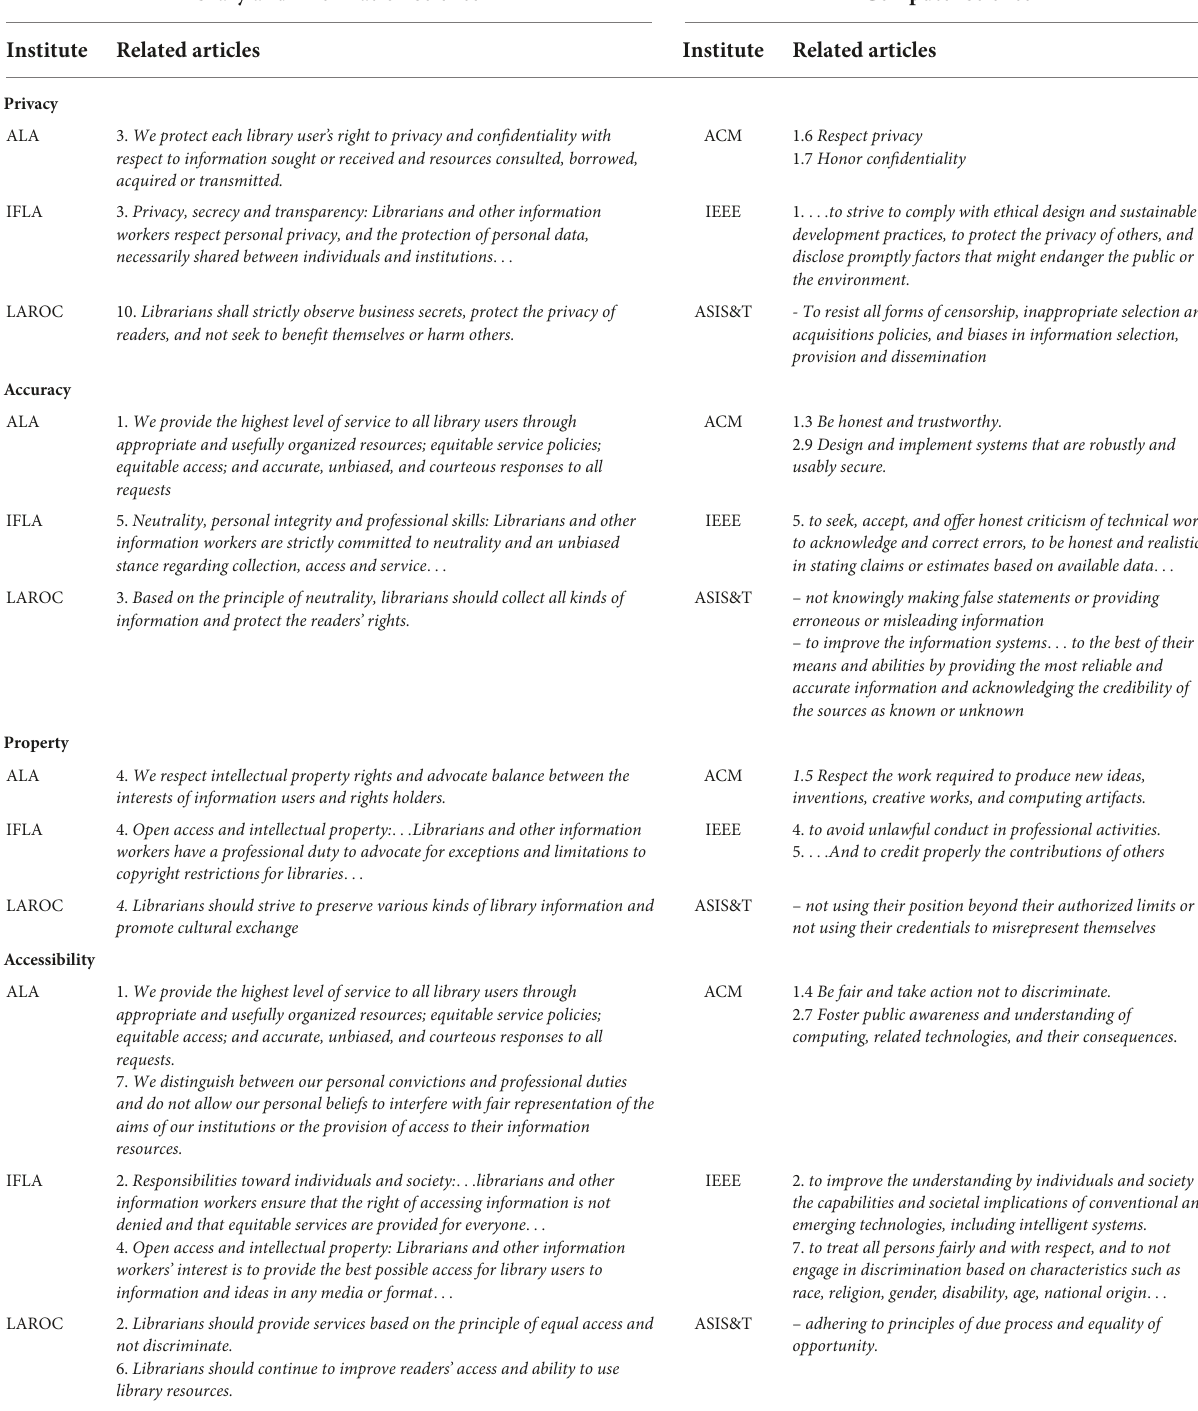
TABLE 1 PAPA-related statements in professional codes of